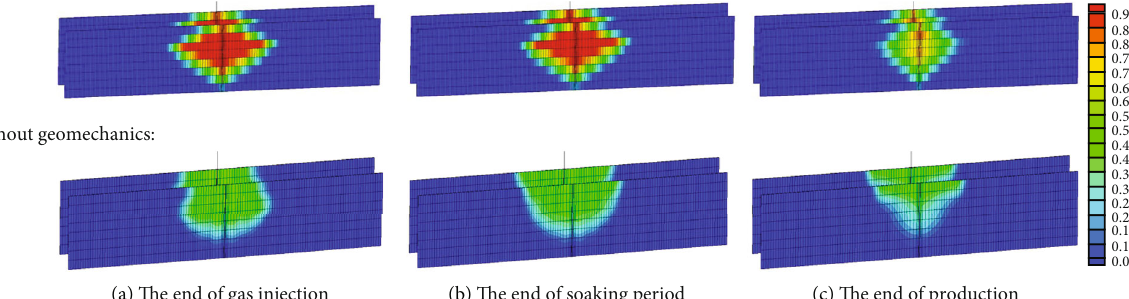
Figure 9: The concentration distribution for CO2.